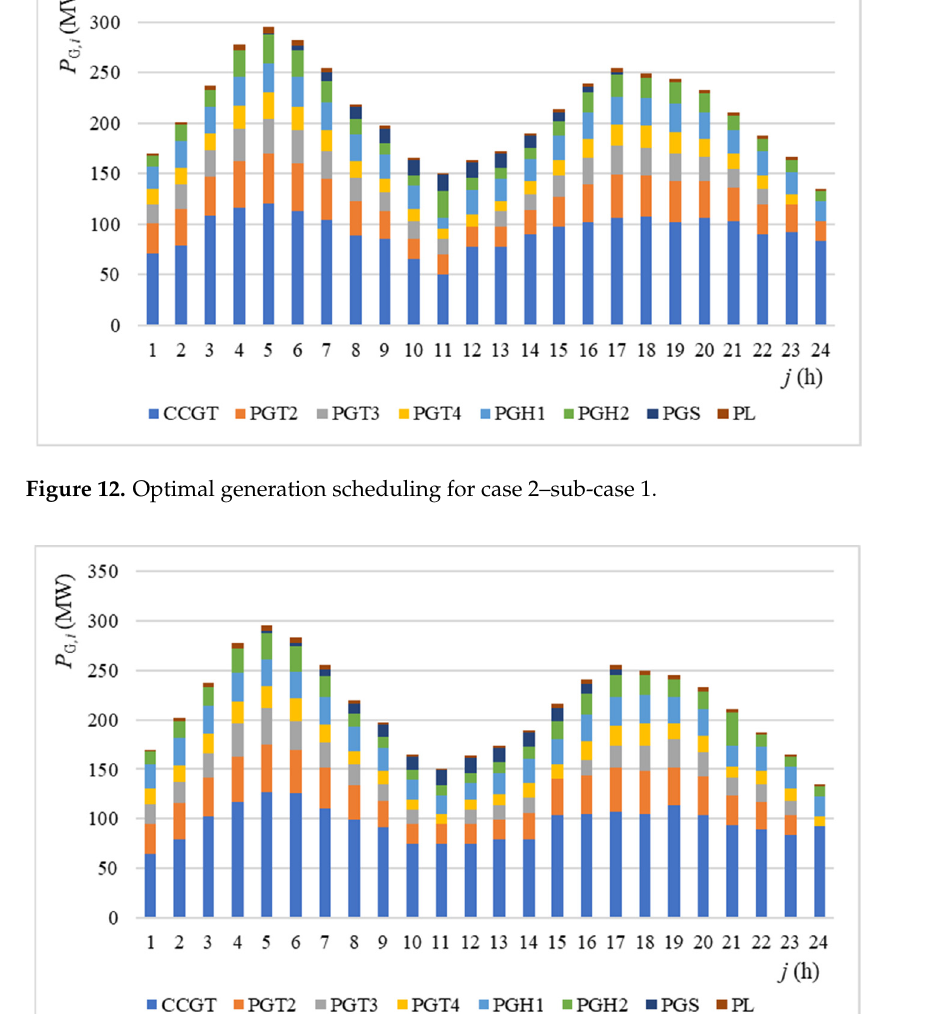
Figure 13. Optimal generation scheduling for case 2–sub-case 2.